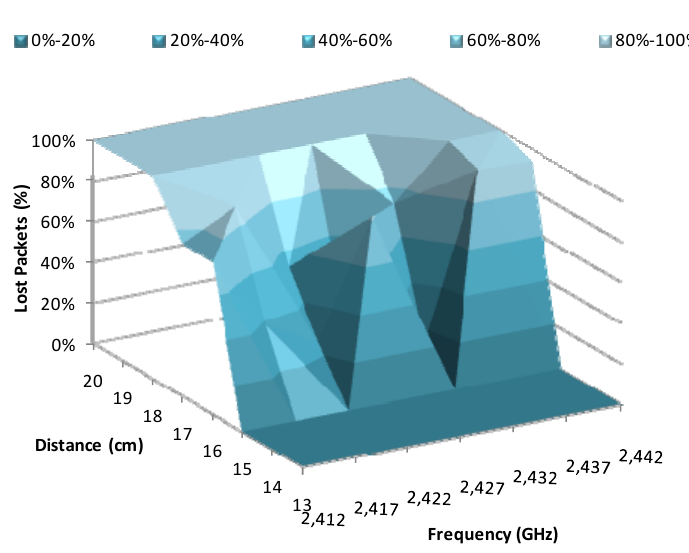
Figure 7. Lost packets for 1 Mbps.